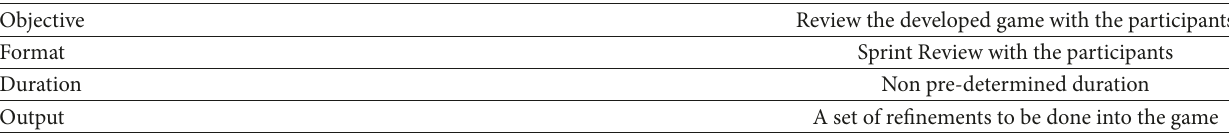
Figure 7: Relationship between body movements and the inputs in the game for controlling the character by gestures in the first version of the game. Table 7: Summary of the characteristics of Session